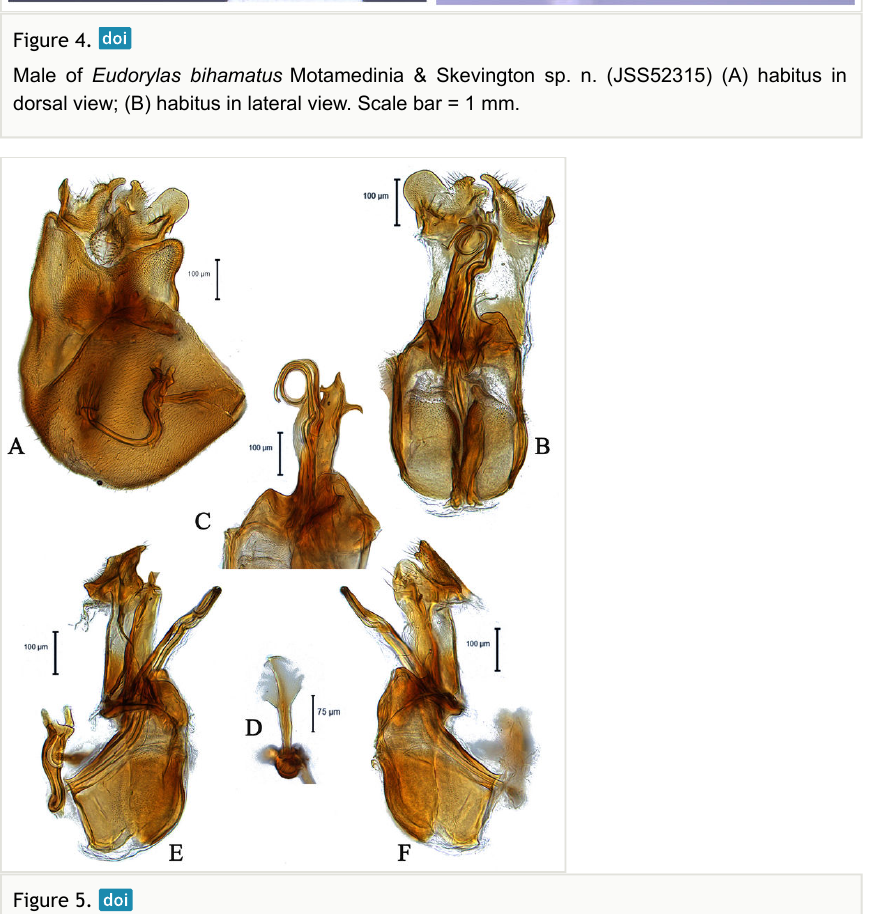
Figure 5. Male genitalia of Eudorylas bihamatus Motamedinia & Skevington sp. n. (JSS52191) (A) in dorsal view; (B) in ventral view; (C) phallus and phallic guide in ventrolateral view; (D) ejaculatory apodeme; (E, F) in lateral